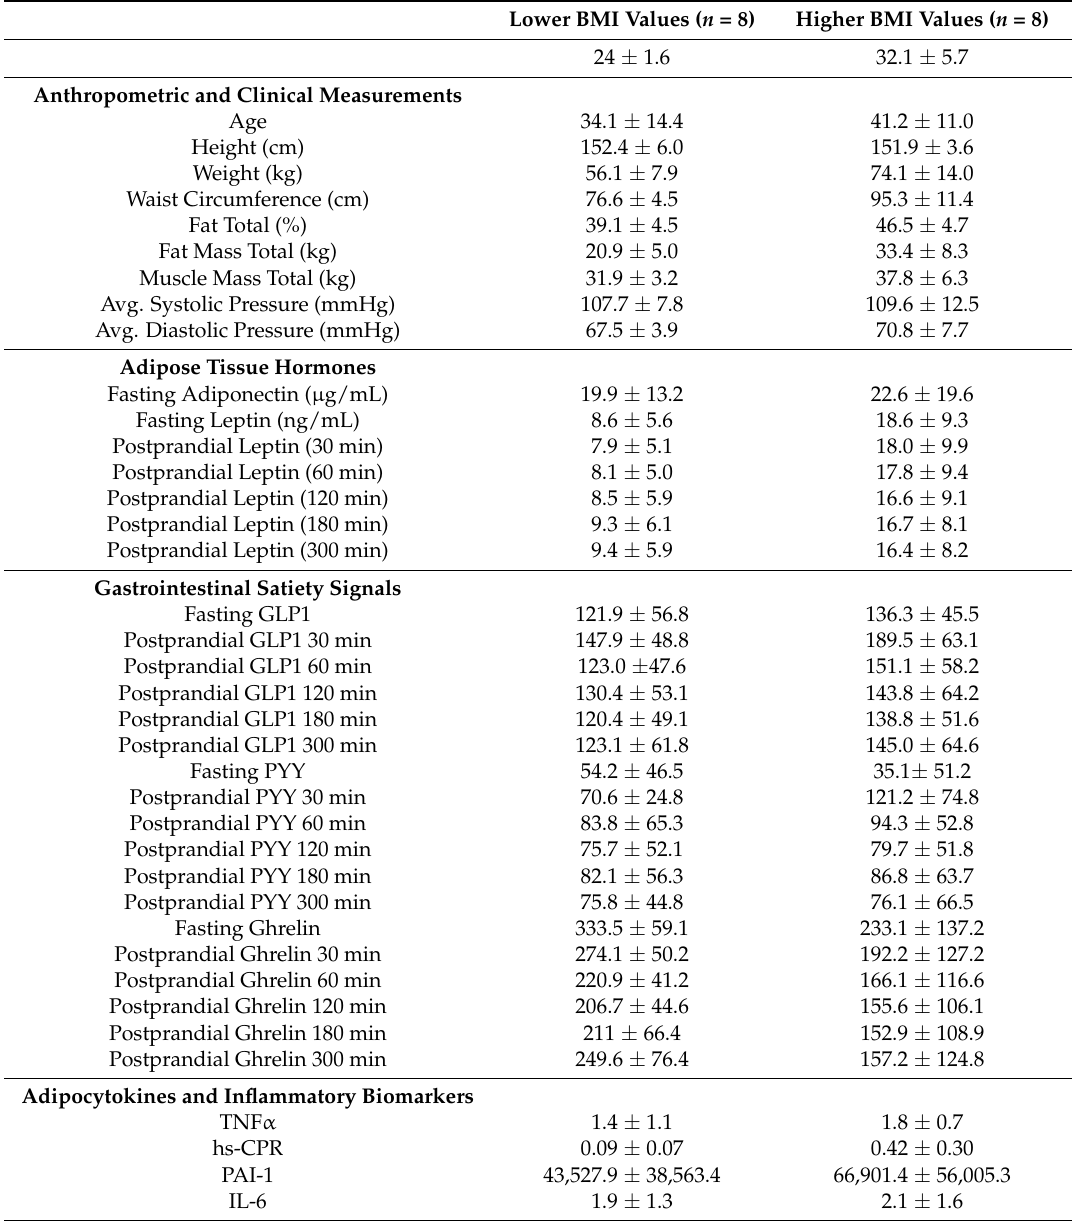
Table 1. Fasting and postprandial phenotypes related to body composition, adipocyte biology, incretins, hunger and satiety, and immune system